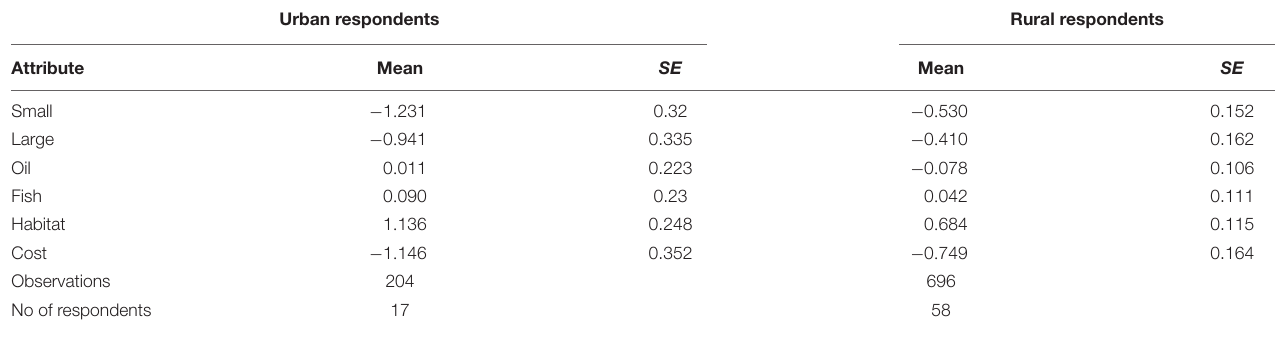
TABLE A3 | Preference estimates for urban and rural respondents in coral